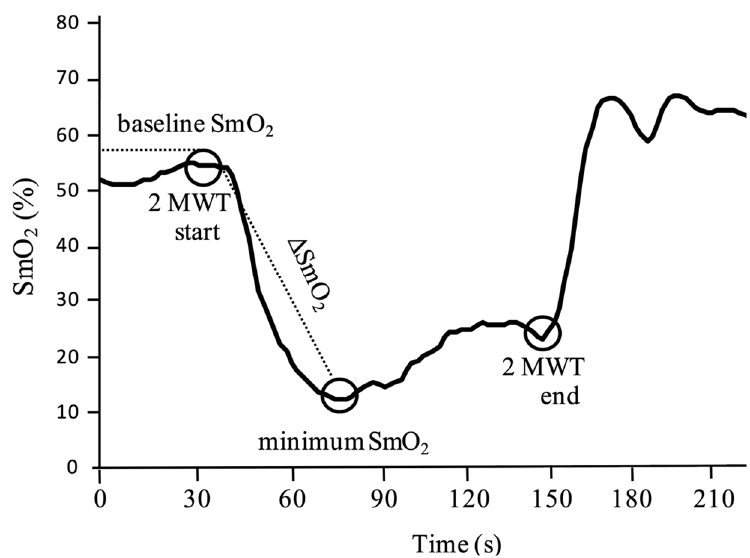
Figure 1. Calculation method for SmO 2 parameters obtained before and during the 2 MWT. The average SmO 2 value during the 30 s of rest before the start of exercise was defined as the baseline, then the minimum value of SmO 2 during exercise was calculated. The difference between these values was defined as Δ SmO 2 .